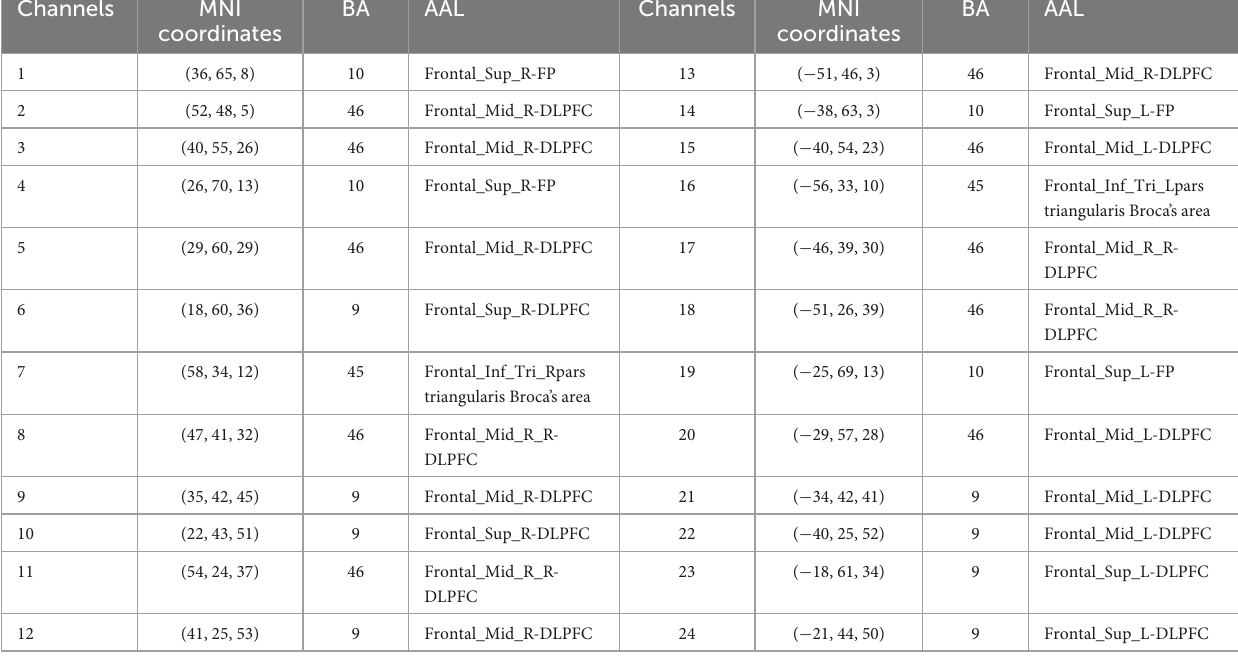
TABLE 2 The cortical locations corresponding to the channels.